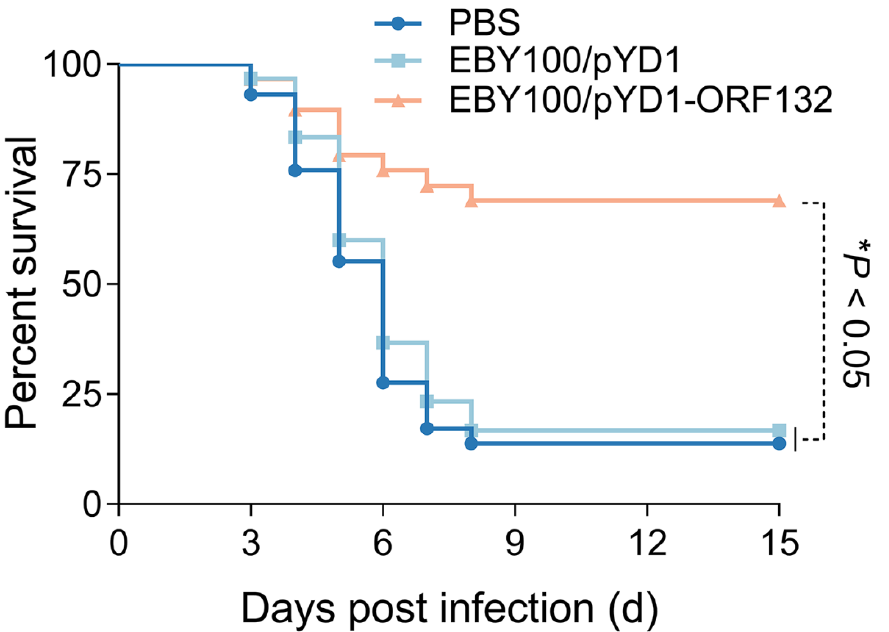
Figure 5. The cumulative mortality of vaccinated crucian carp. Mortality was recorded daily and analyzed based on the Kaplan–Meier survival curves, * p < 0.05.